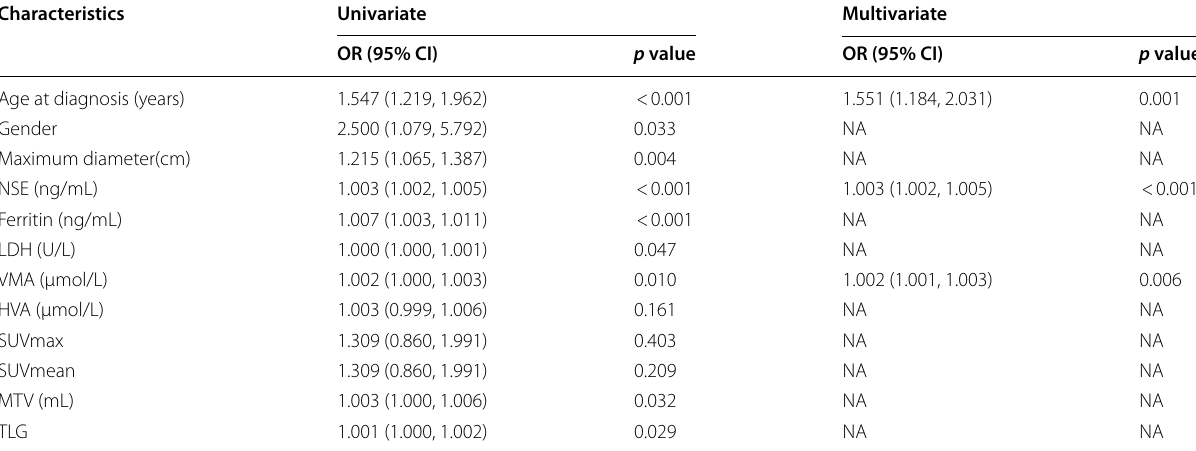
CI Confidence interval, HVA Homovanillic acid, LDH Serum lactate dehydrogenase, MTV Metabolic tumor volume, NA Not available, NSE Neuron-specific enolase, OR Odds ratio, TLG Total lesion glycolysis, VMA Vanillylmandelic acid